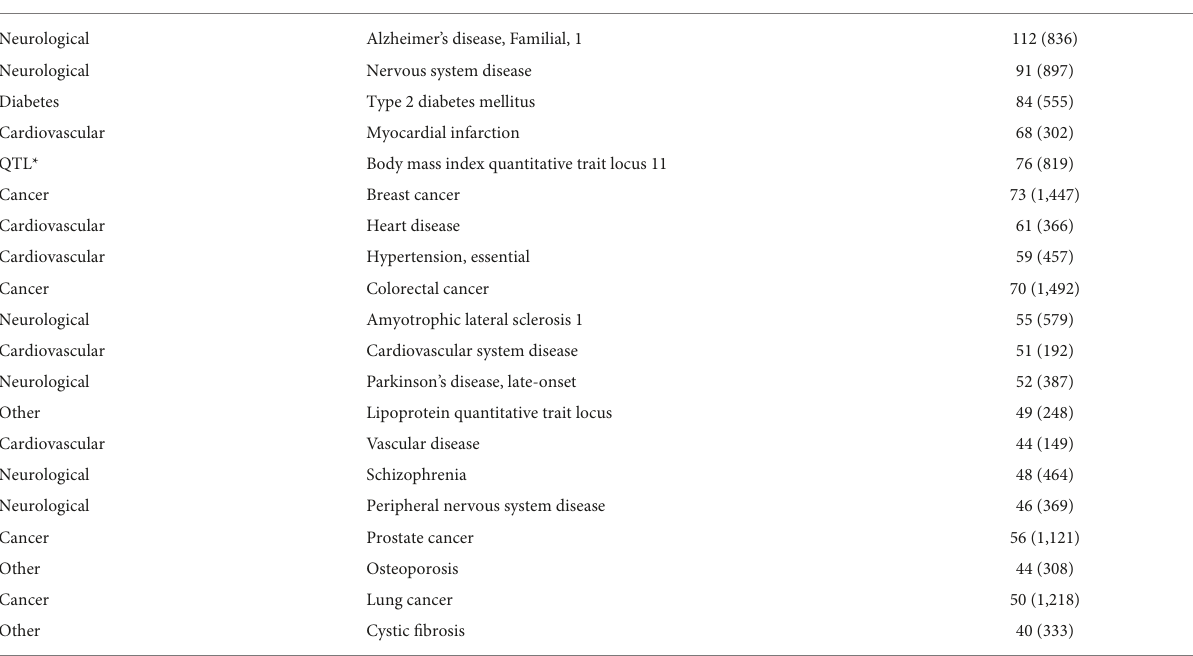
TABLE 2 Diverse disease hallmarks are associated with AD genes. General